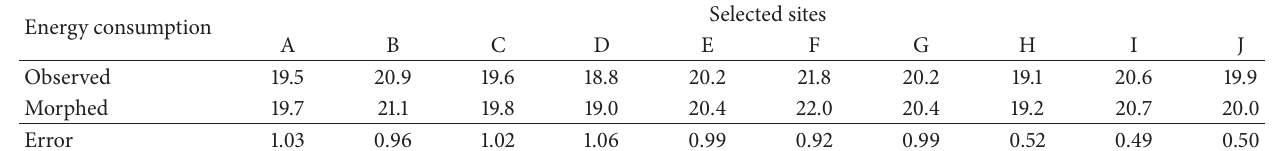
Table 5: Energy consumption for cooling based on observed and morphed weather data.